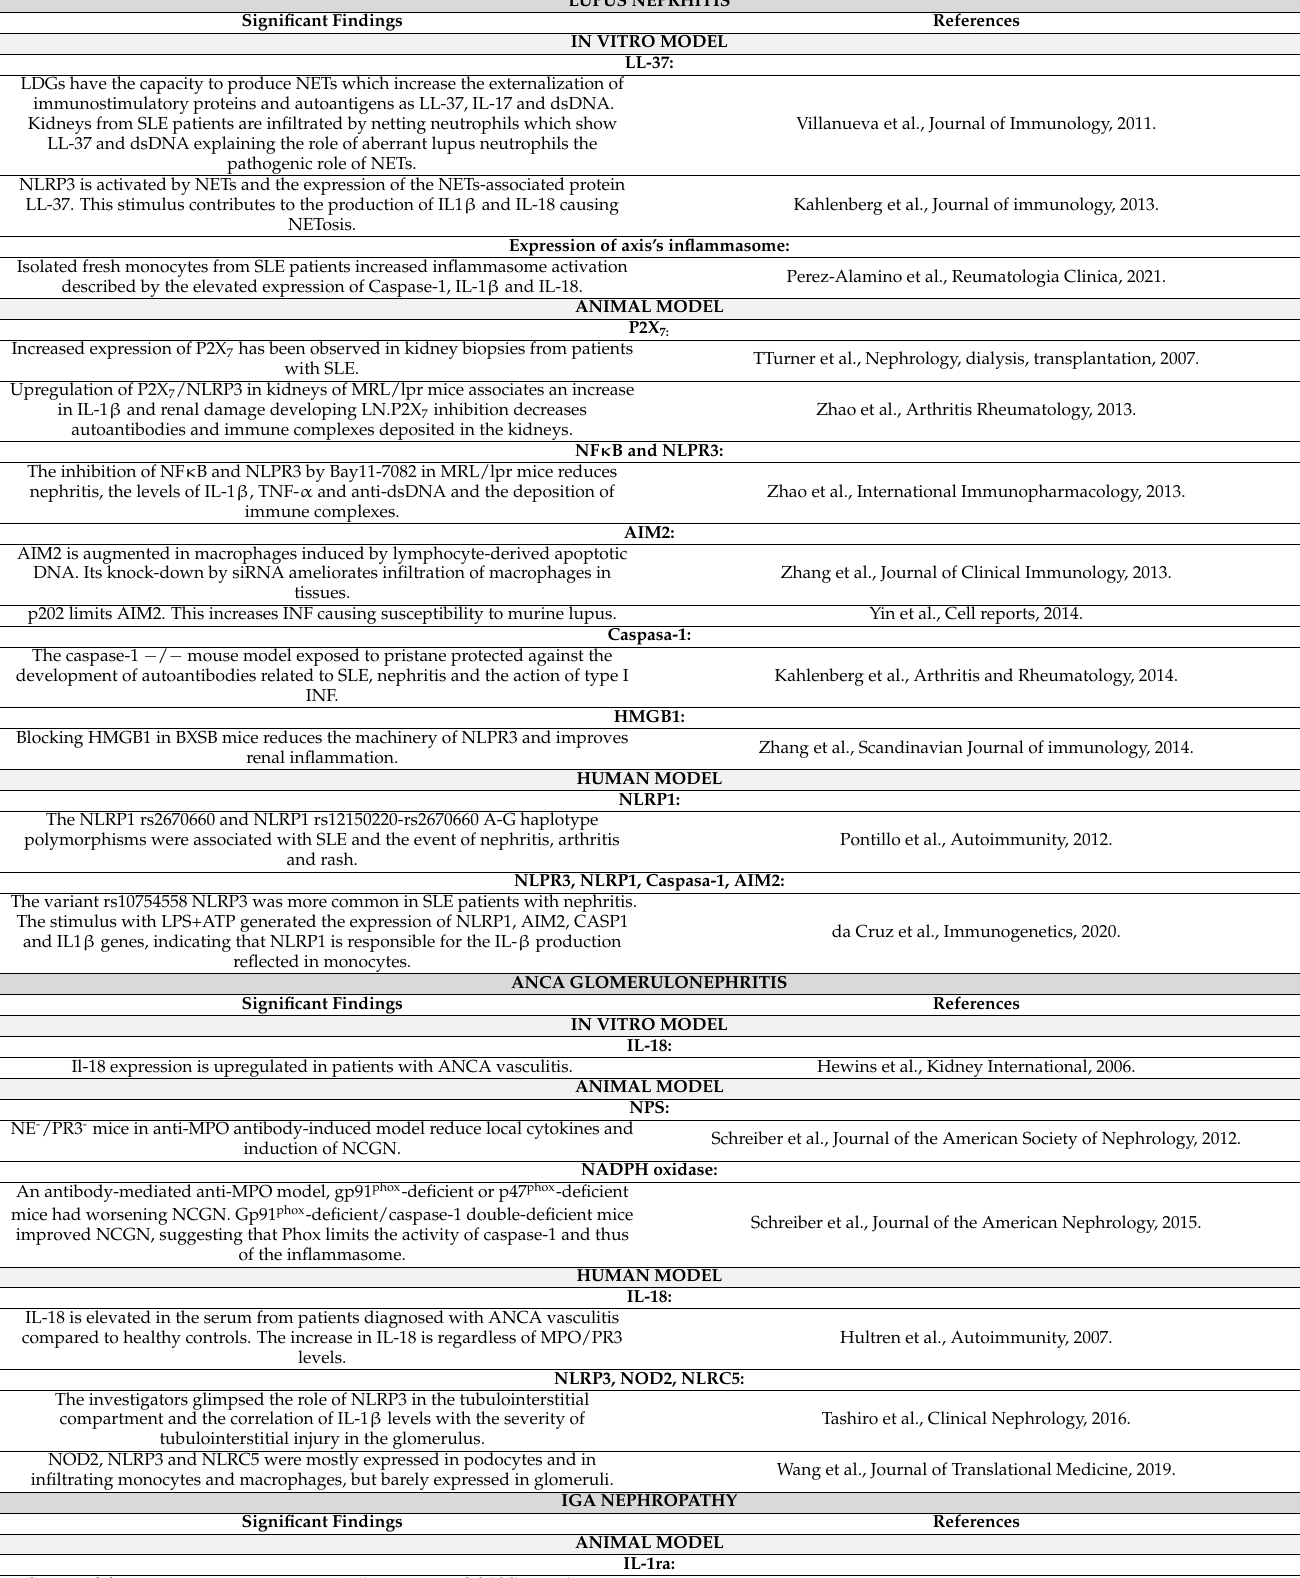
Table 1. Summary table: studies about the inflammasome’s role in